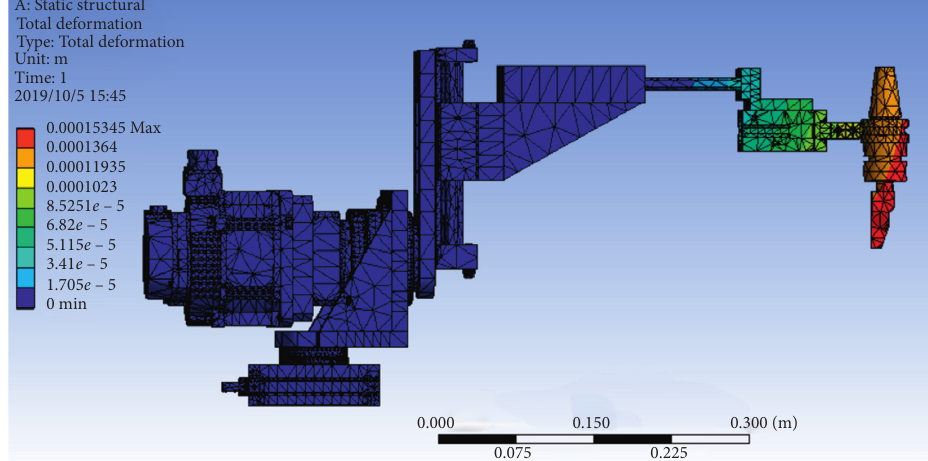
Figure 7: Static mechanical finite element analysis of the structure of the tool change arm.